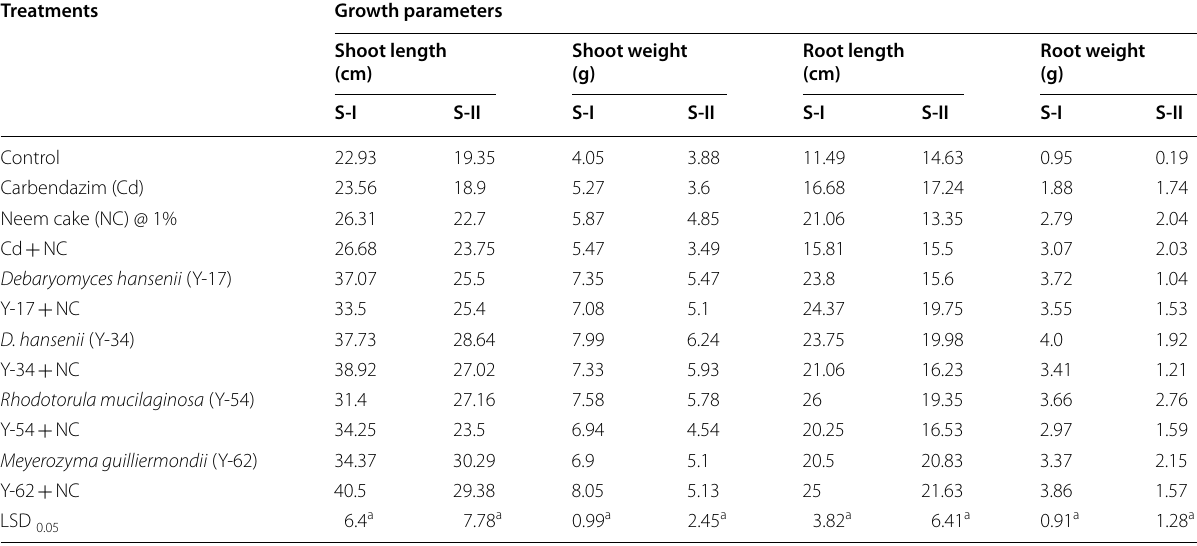
Table 2 Effect of endophytic yeast isolates on vegetative growth of tomato plants in natural soil and soil amended with neem cake in pots experiment—season I and II